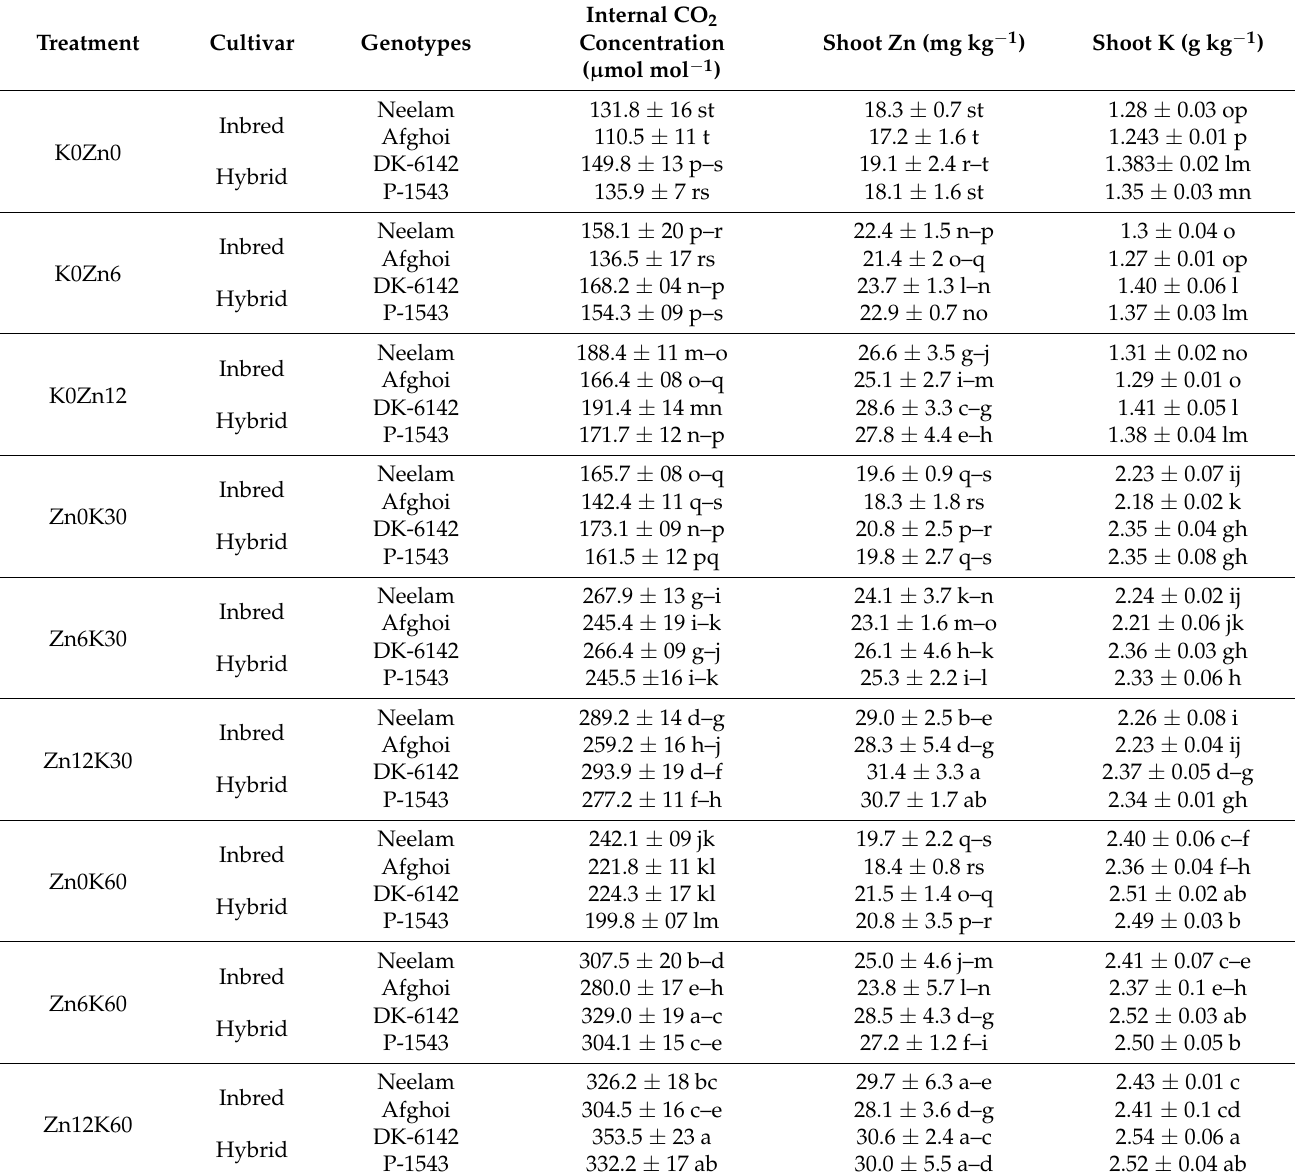
Table 4. Effect of K and Zn on nutrient